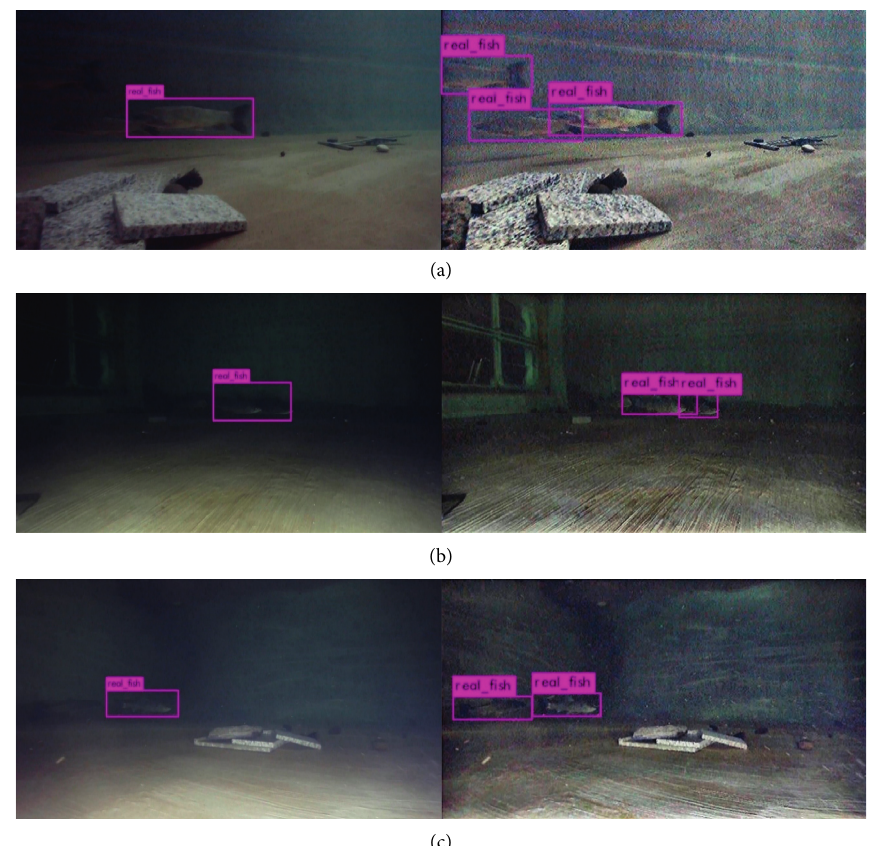
Figure 10: Comparison of fish detection between original image and restored image in three environments: (a) NL; (b) NOL; (c)